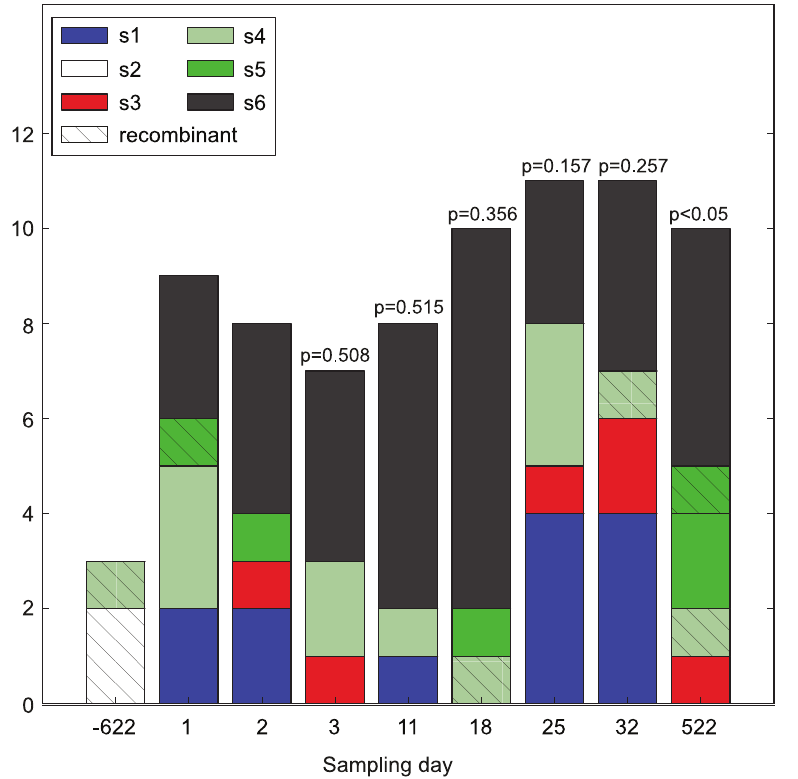
Figure 2. Bar chart showing the observed within-patient frequency fluctuations of the genetic subpopulations during the study period. Subpopulations as defined in Figure 1 are shown in respective colour and recombinant sequences are marked with diagonal stripes. P-values for tests of constant within-patient subpopulation frequencies are shown above the histogram for each day. Thus for each day J , subpopulation frequencies w i of days 1… J -1 are compared to the w i frequencies of day J . See text for details.